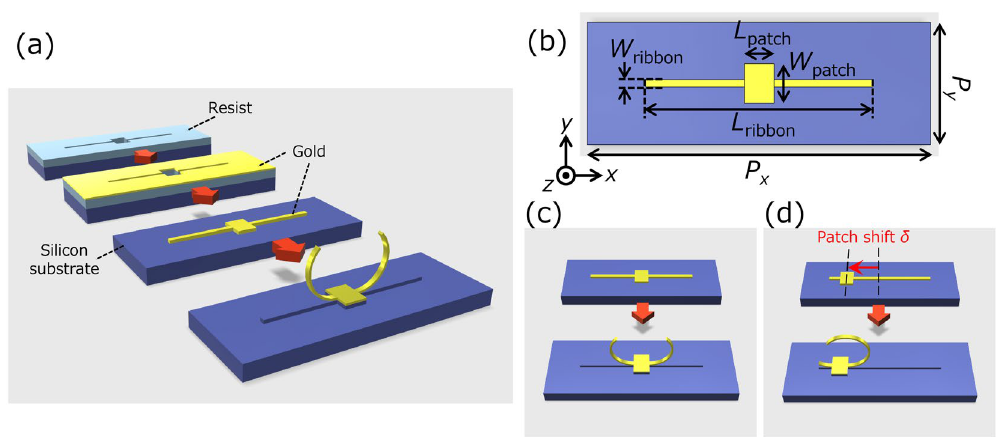
Figure 2. ( a ) Fabrication step of a metal-stress-driven self-folding method. ( b ) The design of 2D gold patterns. ( c ) 3D structures after folding with and without the patch shift δ .